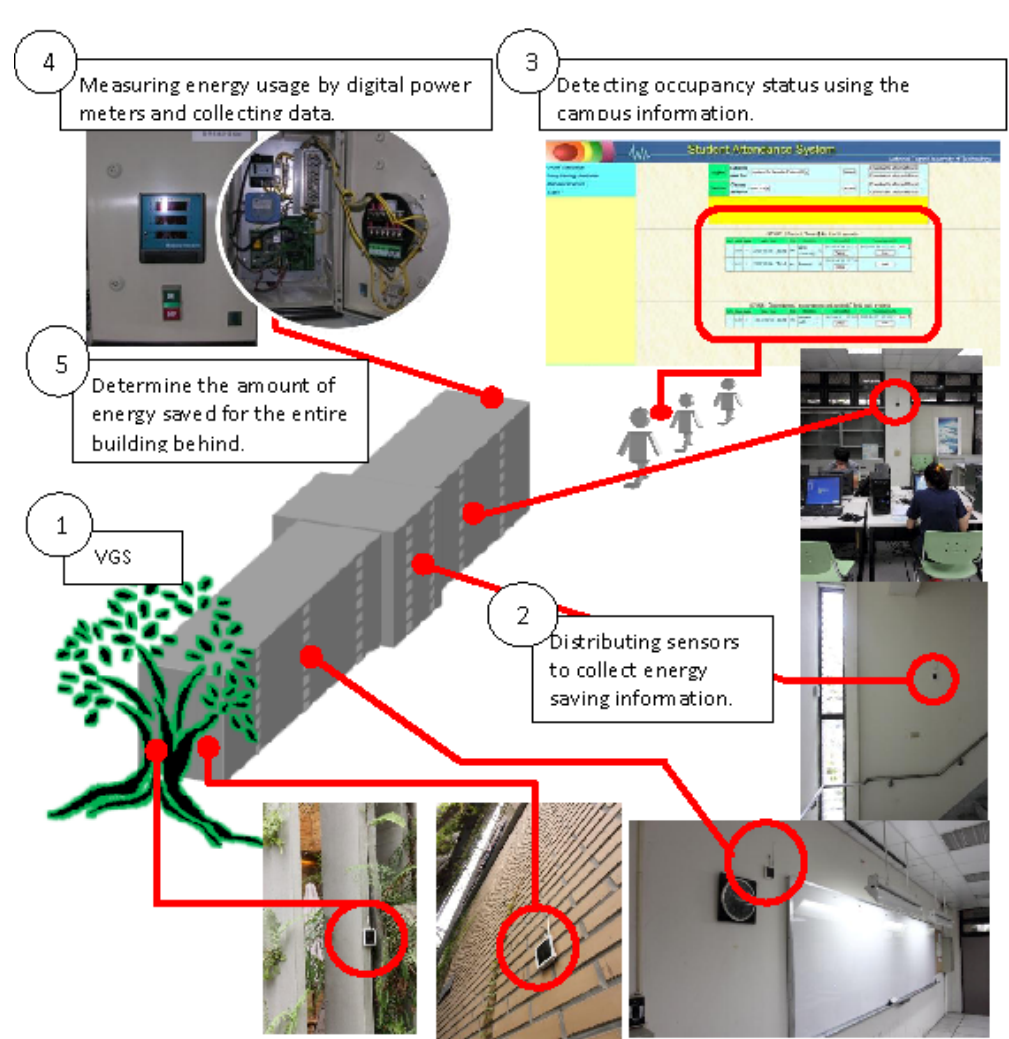
Figure 5. Sensor